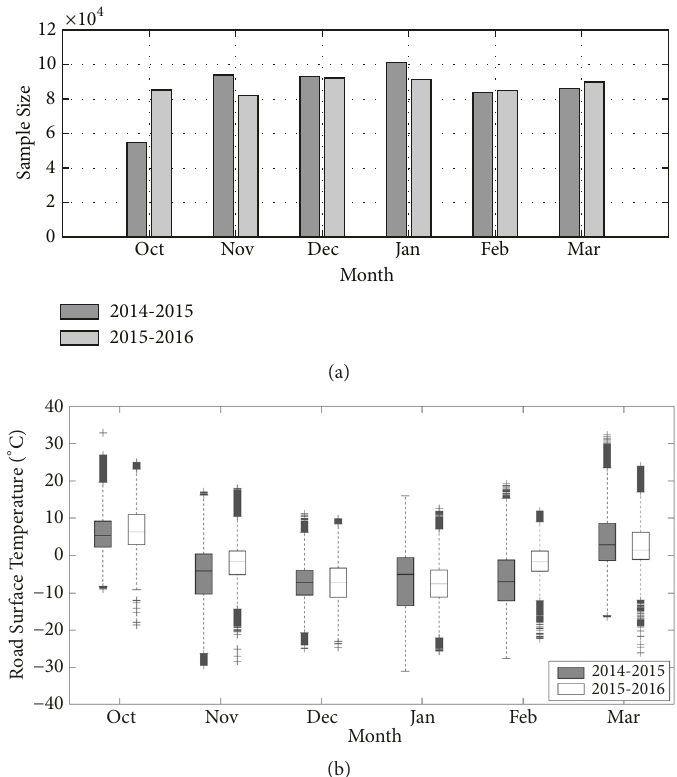
Figure 5: Data summary after data quality check. (a) Monthly sample size. (b) Boxplot of the processed